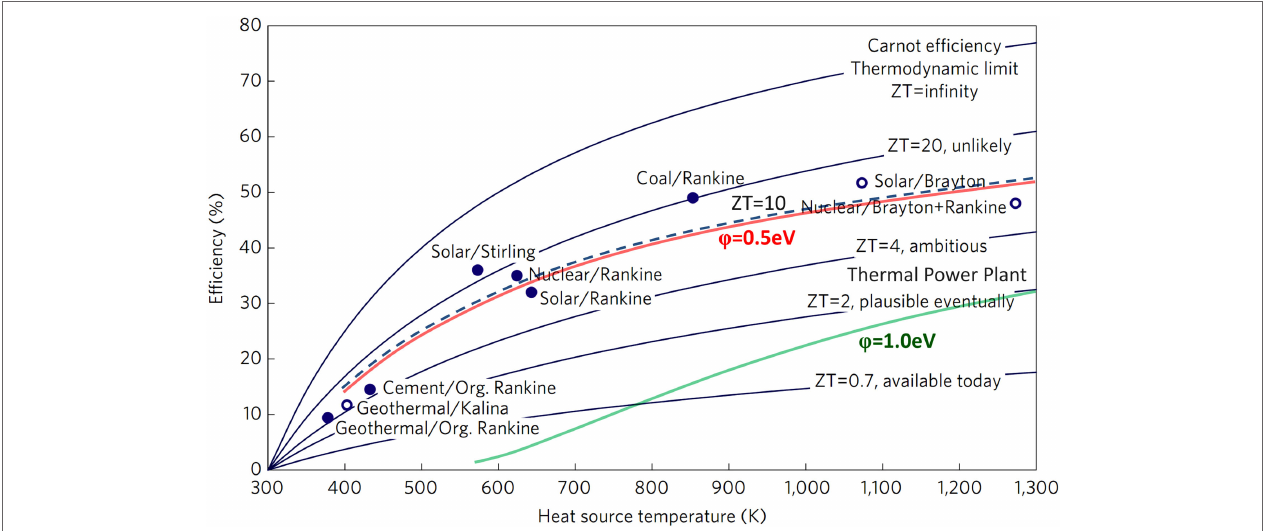
FIGURE 1 | Efficiency for various power generators compared to thermoelectric conversion with figure of merit ZT and thermionic conversion efficiency enabled by low work function collectors (Vining, 2009). With a collector work function of ϕ = 1.0eV efficiencies compare to thermal power plants and for a work function of ϕ = 0.5eV a conversion efficiency of (cid:24) 50% is